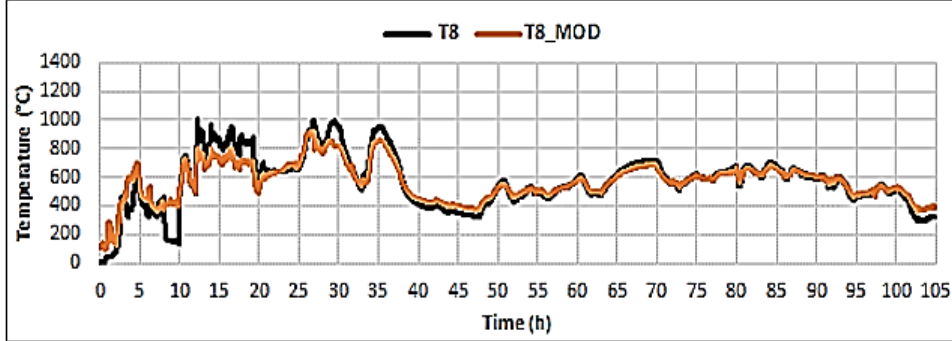
Figure 2. The measured (T) and modeled (T_MOD) temperature behavior [11].